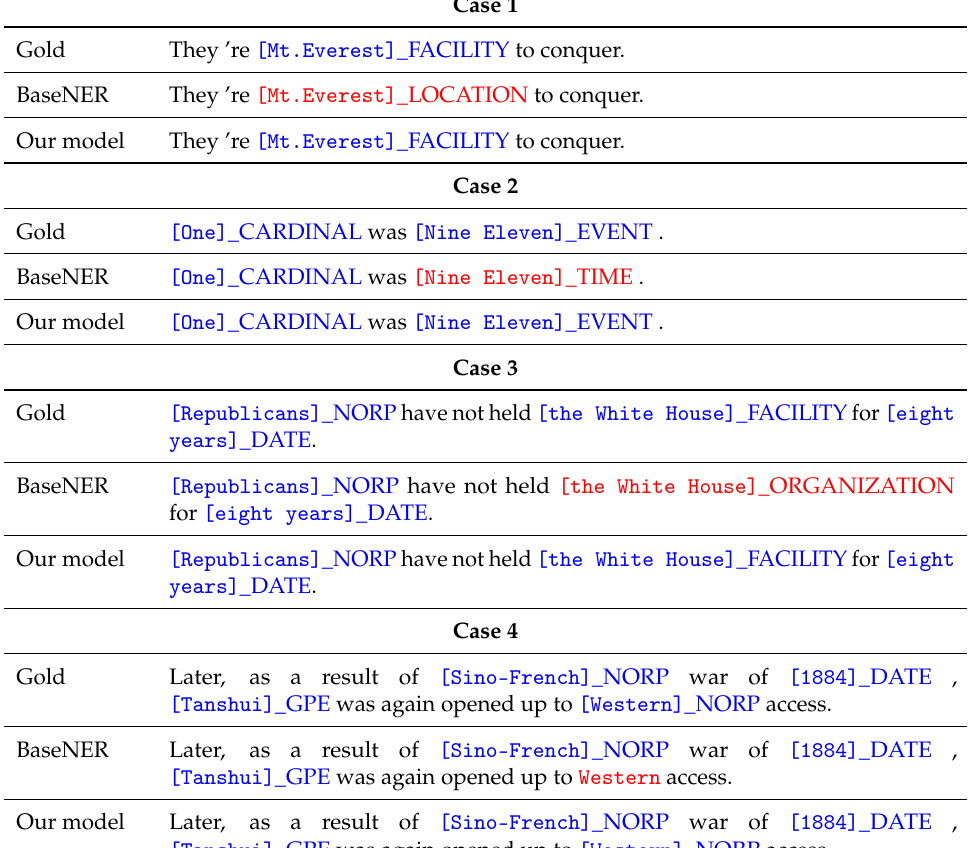
Table 10. Examples of that our model can integrate type chaining structure to constrain entity types, while the BaseNER cannot.